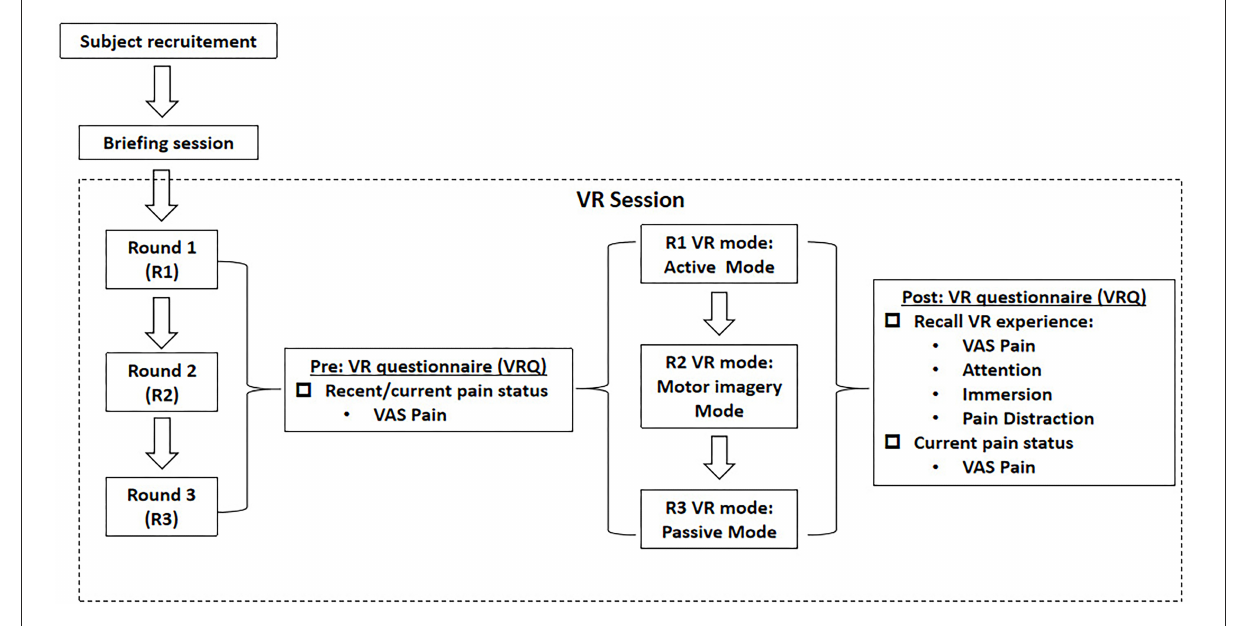
FIGURE1 Experimental flow.